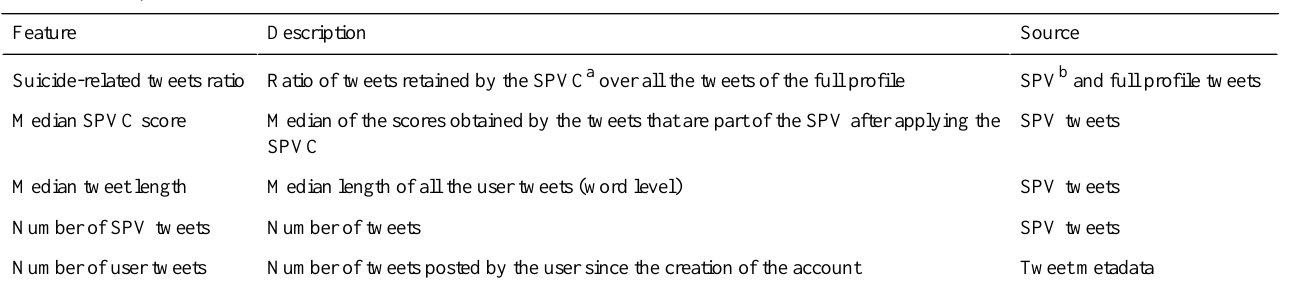
Table 2. Description of features based on tweet statistics.